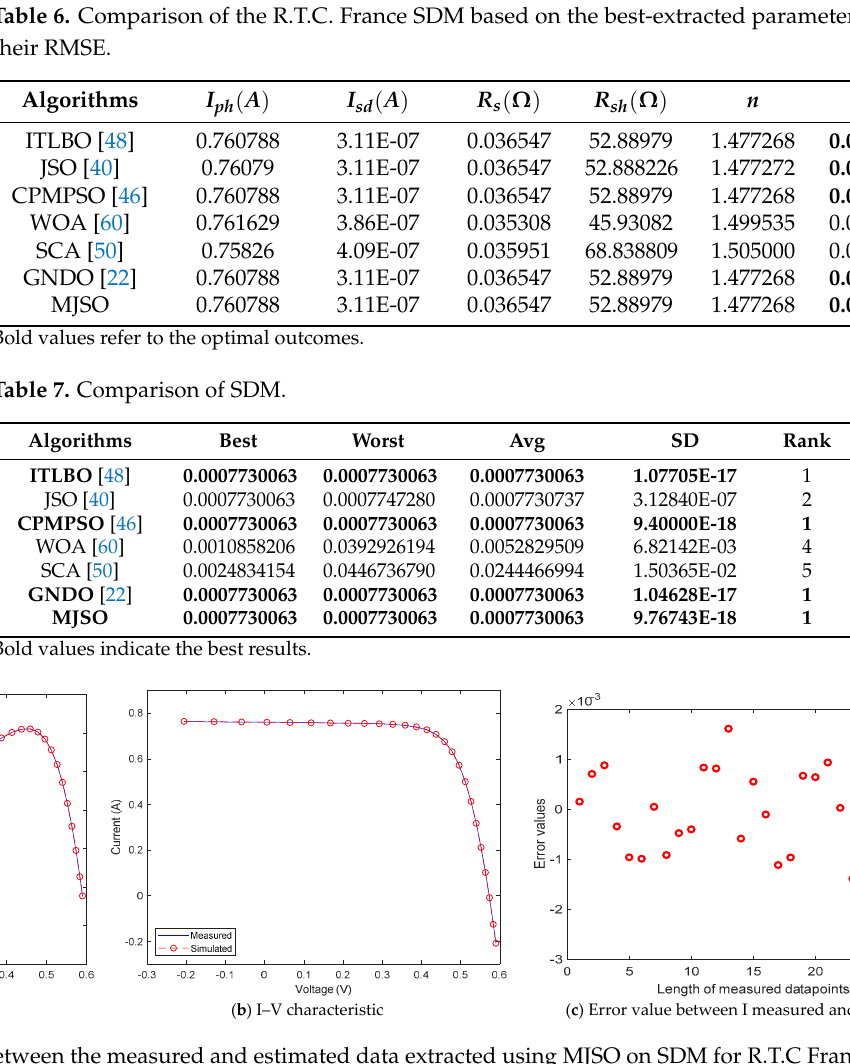
Table 8. Comparison on the DDM in terms of obtained parameter and the corresponding RMSE.